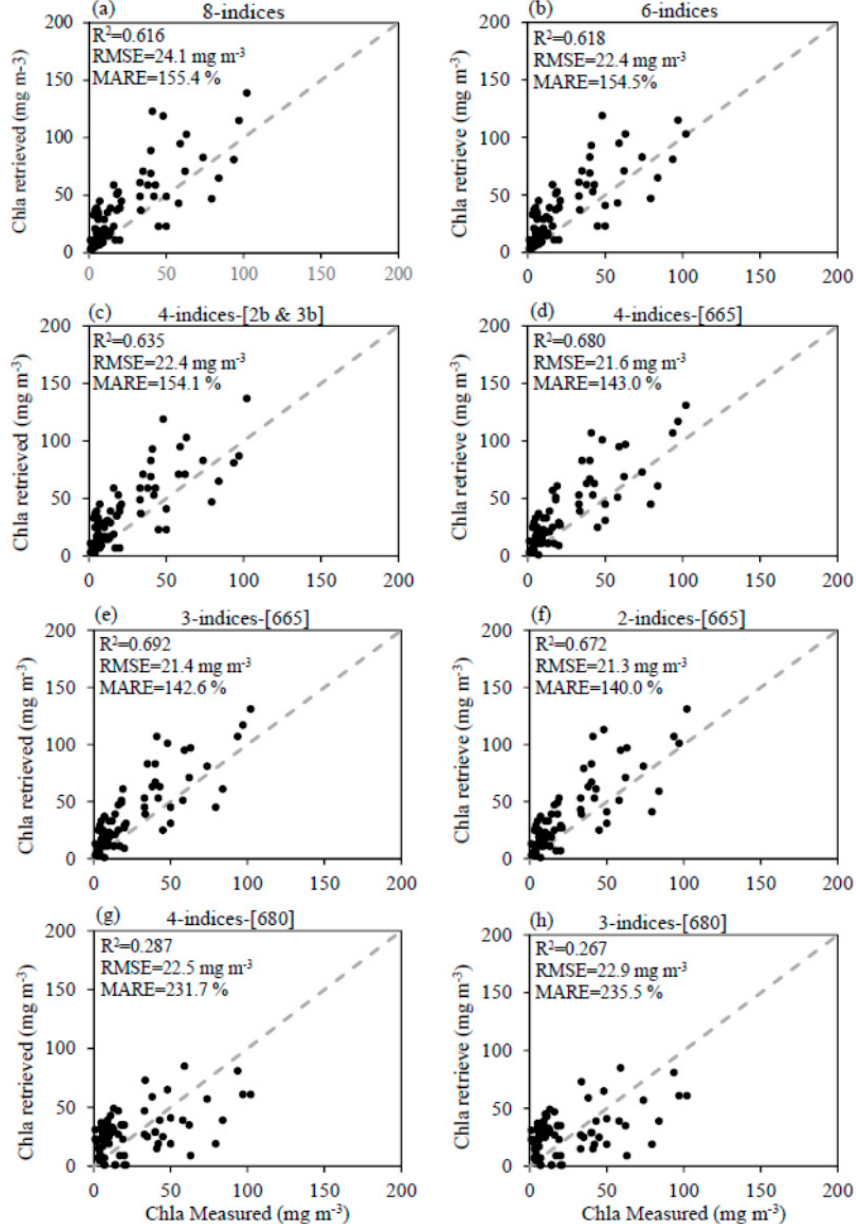
Figure 6. Validation plots between Chla measured in Tokyo Bay (71 stations collected between 2010 and 2013) and retrieved Chla from eight different algorithms’ combinations assessed for MAIN-LUT. Algorithms used in each combination from ( a ) to ( h ) were mentioned in Table 4.